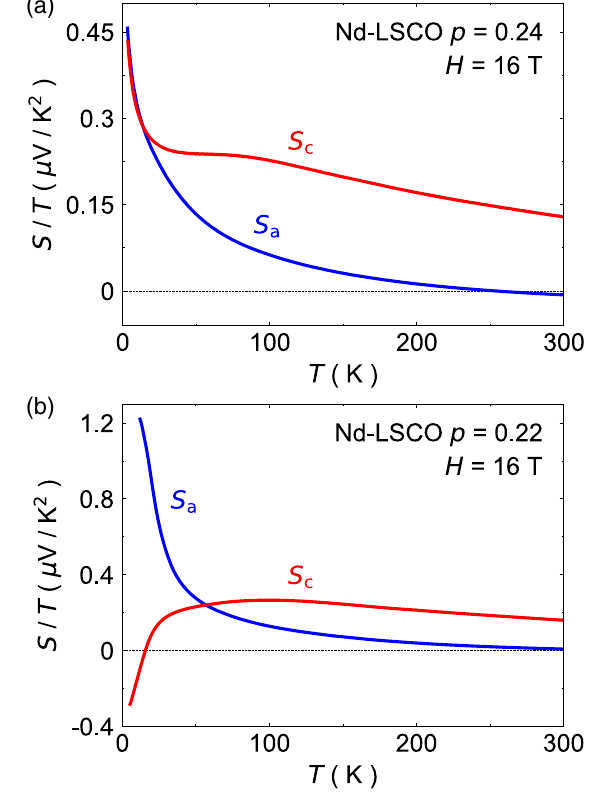
FIG. 2. In-plane ( S a , blue) and out-of-plane ( S c , red) Seebeck coefficient of Nd-LSCO, plotted as S=T vs T at H ¼ 16 T for